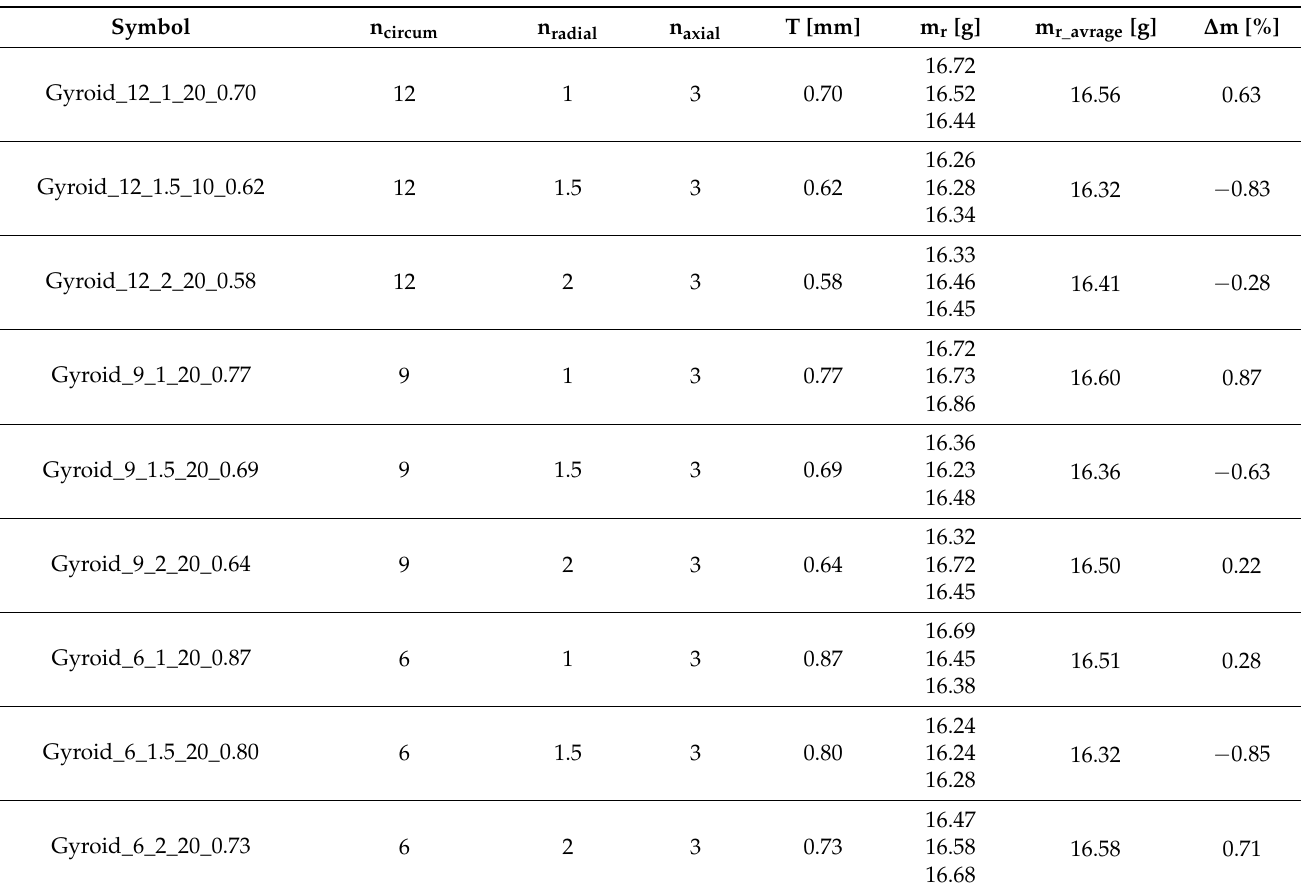
Table 3. Specifications of samples used in this